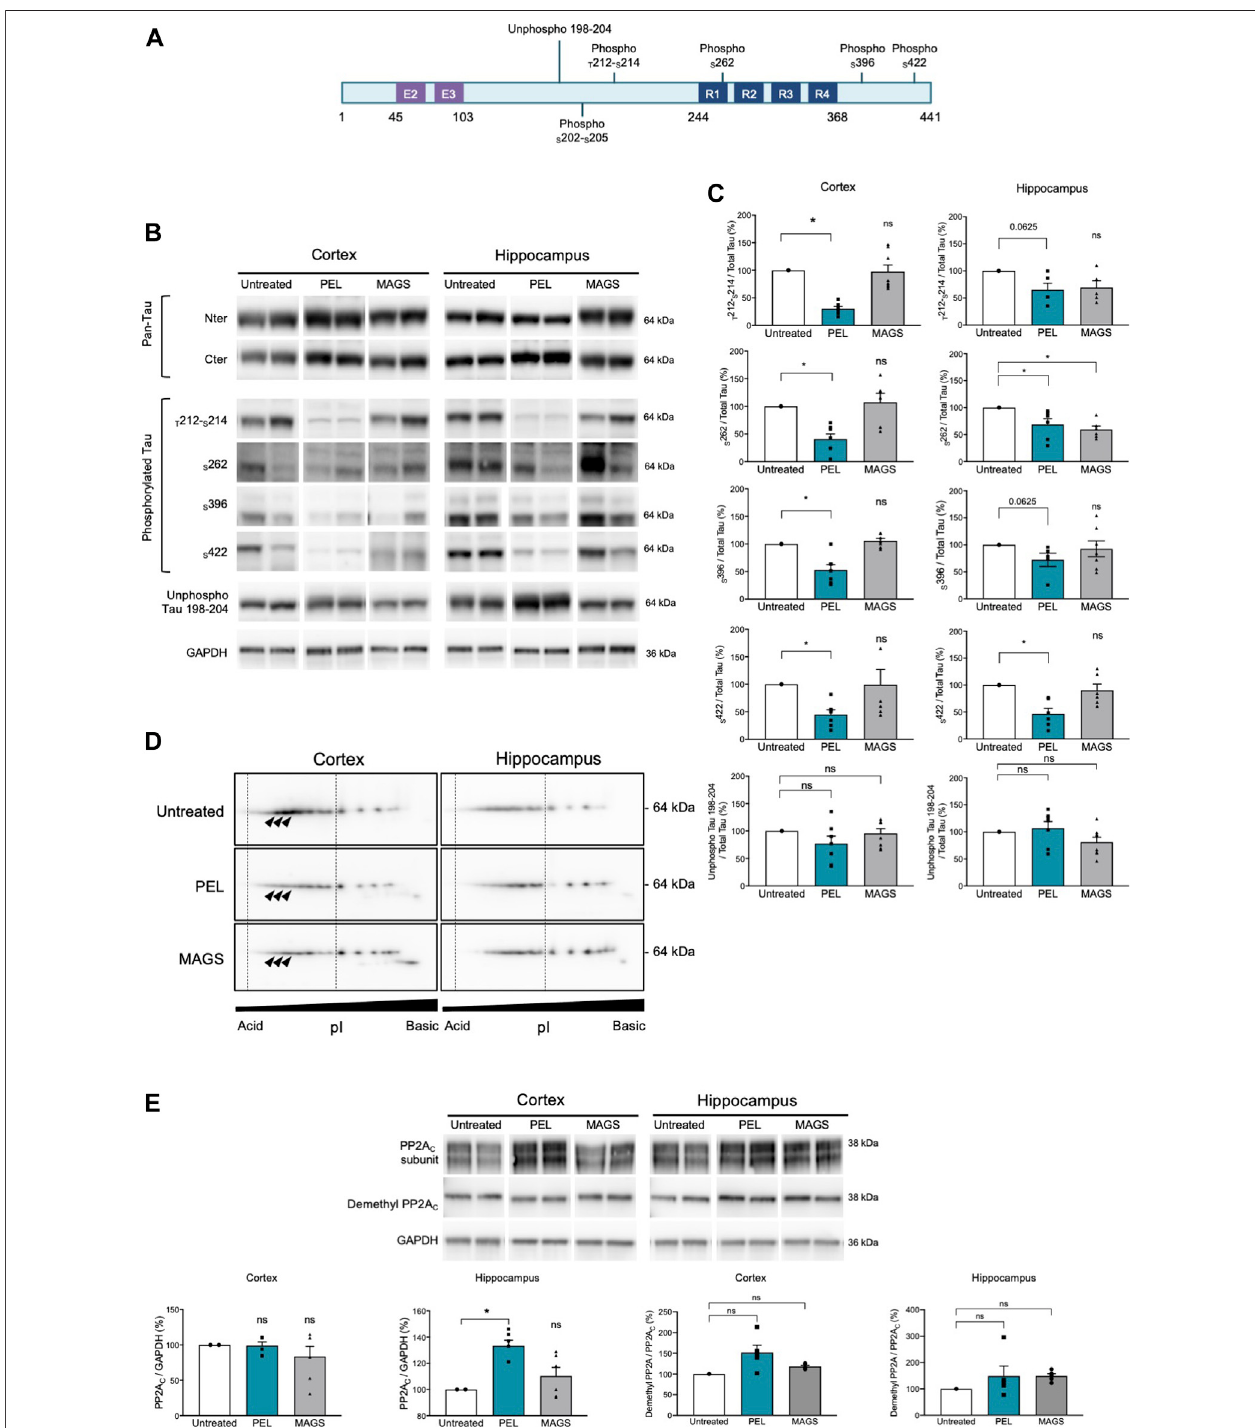
FIGURE2| PEL24-199decreaseshyperandpathologicaltauphosphorylationandincreasesPP2A C expression. (A) Positioningofunphospho-orphosphorylated epitopes recognized by tau antibodies (numbering according to the longest human brain tau isoform of 441 amino acids). Exon two and exon three encoding sequence and the microtubule-binding region formed by tau repeated sequences numbered R1 to R4 are represented. (B) Western blotting of tau expression using N-terminus (Nter)and C-terminus (Cter)pan-Tau antibodies, andphosphorylatedtauatthreonine212andserine214( T 212- S 214),serine262( S 262),serine396( S 396),serine 422 ( S 422), and unphosphorylated tau residues comprised in tau sequence 198-204 (unphospho Tau 198-204). Antibodies labeling are presented for untreated, PEL, and MAGS-treated animals for protein extracts from the cortex or the hippocampus. (C) Histogram representations of the % of antibodies labeling. The control